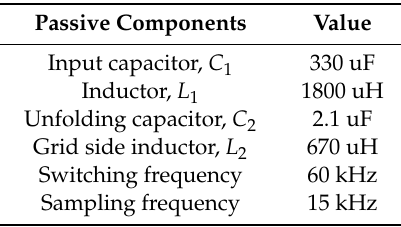
Table 1. Passive components used for simulation verification.